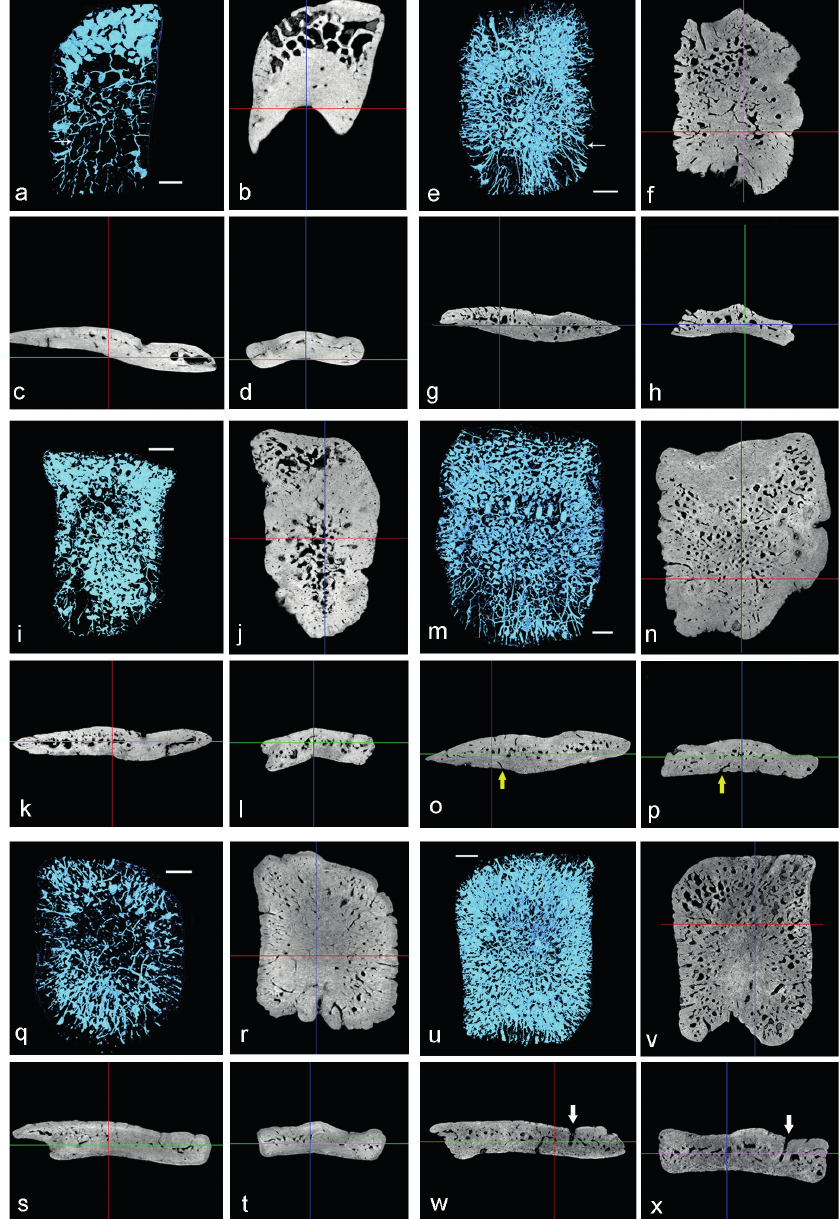
Figure 5 - three-dimensional reconstruction of the porosity and internal view of osteoderms of Riosthegotherium yanei , showing the differences between Pattern 1 (a-d, q-t) and Pattern 2 (e-p, u-x) . a) UFrJ-DG 317M, exhibiting large and irregular cavities anteriorly; b) LMh 06; c) MCN-PV 1777; d) MCN-PV 1779; e) MCt 3932M; f) MCN-PV 1775. Scale bar = 1 mm. a-p , osteoderms from movable bands; q-x , buckler osteoderms. a , e , i , m , q , u , 3D reconstruction; b , f , j , n , r , v , dorsoventral view, anterior to the top; c , g , k , o , s , w , longitudinal view, anterior to the right; d , h , l , p , t , x , transversal view, dorsal to the top. White thin arrows indicate possible havers and Volkmann channels. White thick arrows indicate the glandular cavity internal to piliferous foramina. Yellow thick arrows indicate hypoderm ingression. Colored lines are software axes exported with the images. three- dimensional reconstructions were made with CtVox and slices with